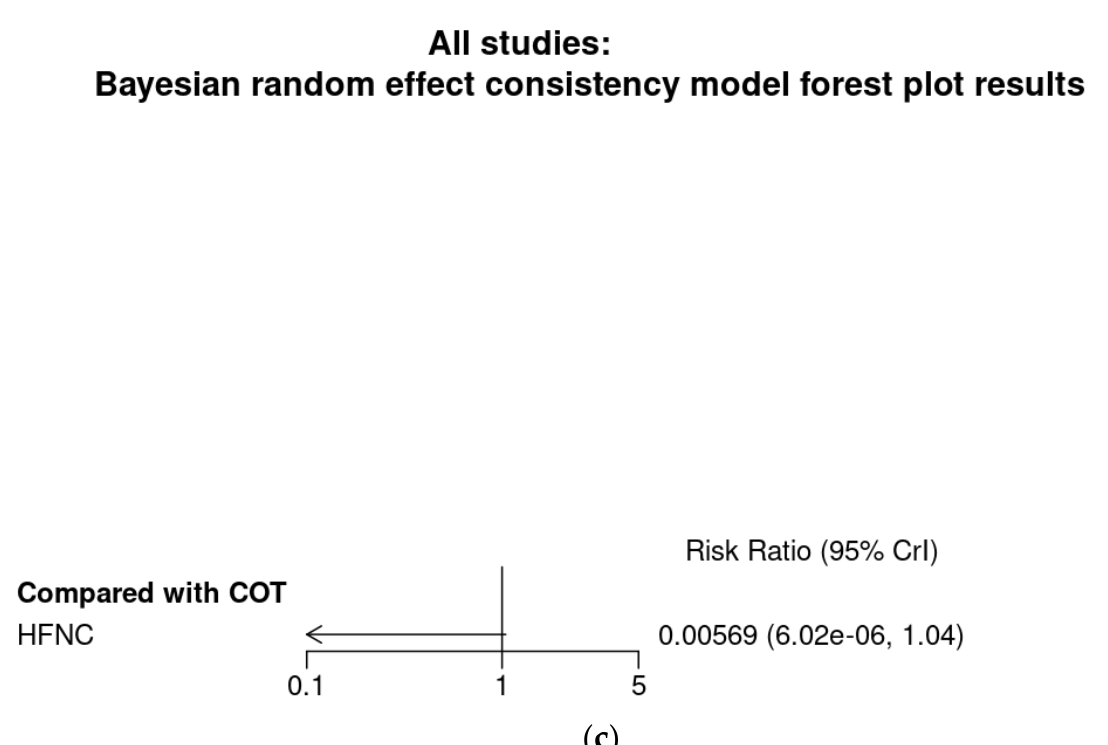
Figure A4. Bayesian random effect consistency model Outcome: Hypoxemia. ( a ) All eight studies. ( b ) Six studies with patients at moderate to high risk for hypoxemia. ( c ) Two studies (Lin et al. [11]) and Teng et al. [12]) with patients at low risk for hypoxemia.